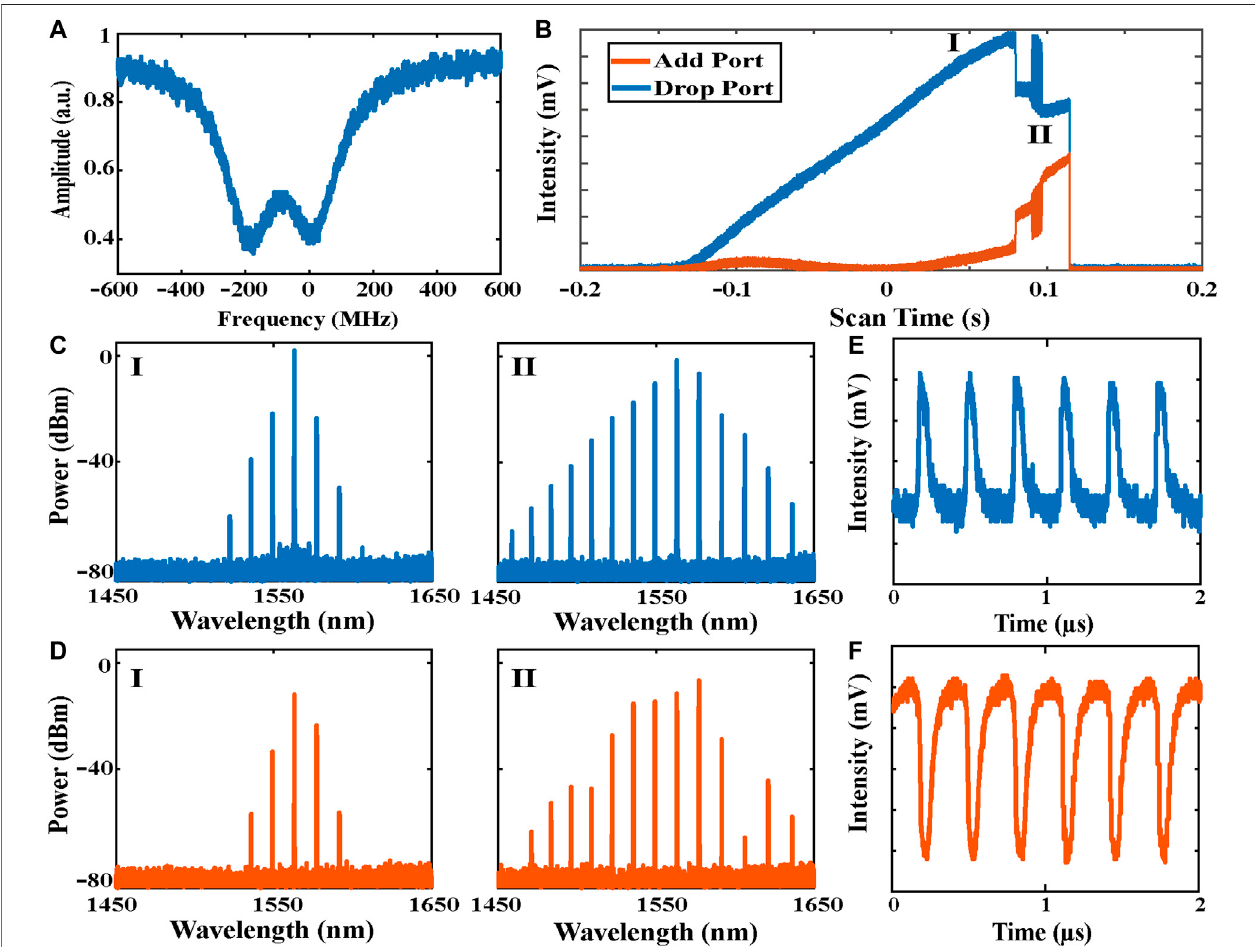
FIGURE3| Breathersoliton via SSBinthemicroresonator withFSRof200G. (A) TransmissiontraceofaresonancesplitduetobackwardRayleigh scattering. (B) MeasuredpowertracesofCWandCCW via frequencytuning.States Ⅰ and Ⅱ are,respectively,inthecascadeFWMstateandbreatherperfectsolitoncrystal(PSC)state. BreatherPSC( Ⅱ )isevolvedfromtheturningpatternandlow-noisemodulationstate.Thepowertracesbifurcateatabout − 0.10s. (C) Ⅰ and Ⅱ are,respectively,theoptical spectrumsofcascadeFWMandbreatherPSCforCWwaves.ThefrequencyspacingsofFWMandbreatherPSCare,respectively,11-FSRand9-FSR. (D) Optical spectrums of FWM and PSC for CCW waves. (E,F) Power traces of CW and CCW optical fi eld at the breather soliton region.